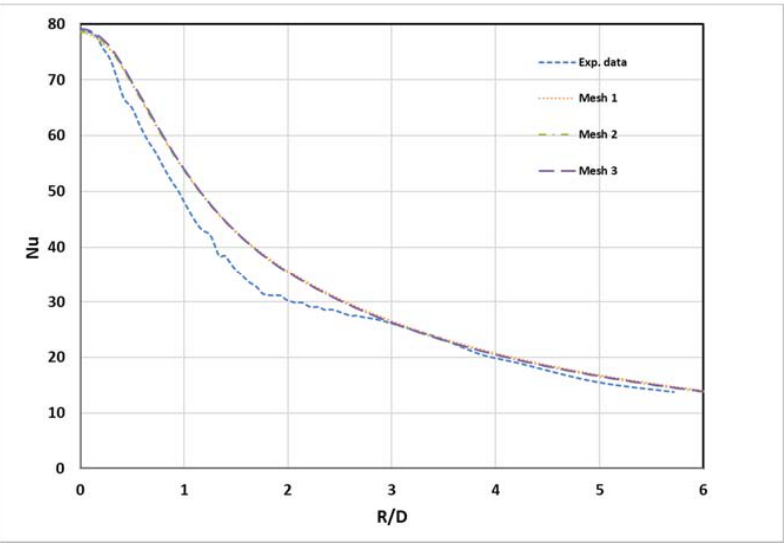
Figure 4. Nusselt number distribution for three mesh grids, jet-to-target distance H/D = 6, R e = 10,000.